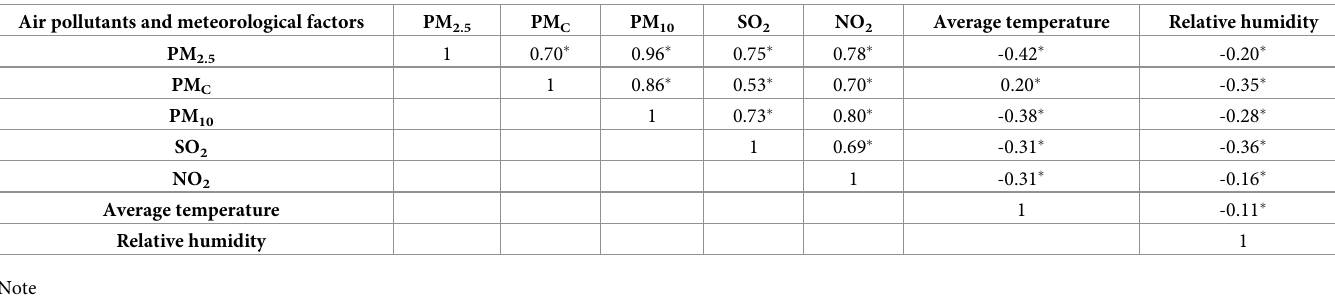
Table 2. Spearman correlation coefficients between air pollutants and meteorological factors. Air pollutants and meteorological